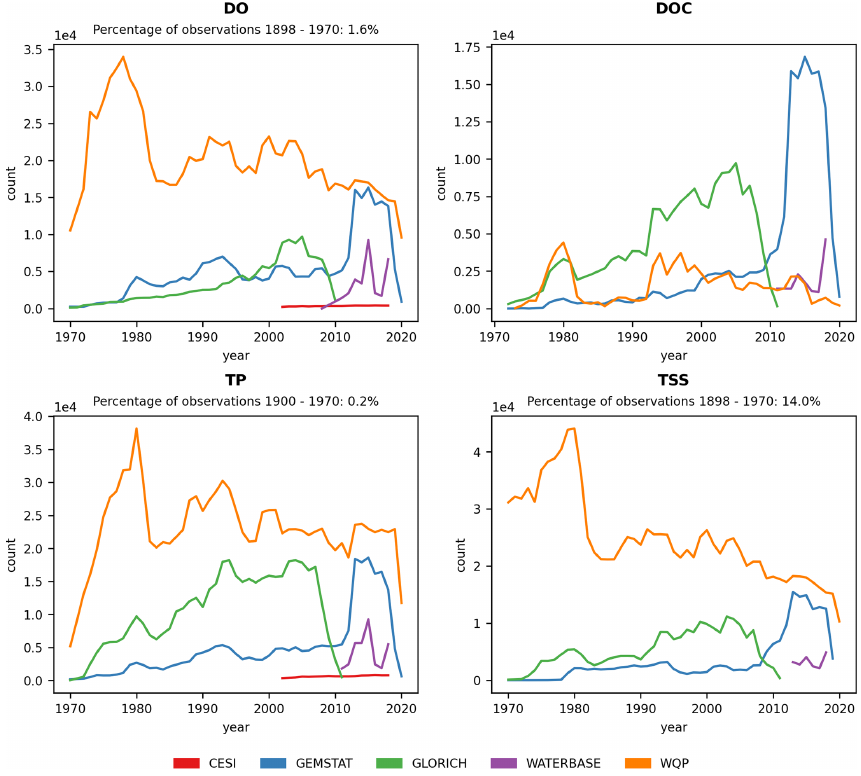
Figure 3. Temporal distribution of observations for dissolved oxygen (DO), dissolved organic carbon (DOC), total phosphorus (TP) and total suspended solids (TSSs) for the period 1970–2020. The percentage of observations before the period shown on the plot is given for each parameter. Only seven observations (1 . 69 × 10 − 5 %) existed for DOC in the 1968–1970